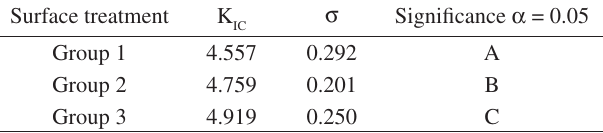
only validated if the crack began at the corners of Vickers indentation. Different letters indicate statistical difference between